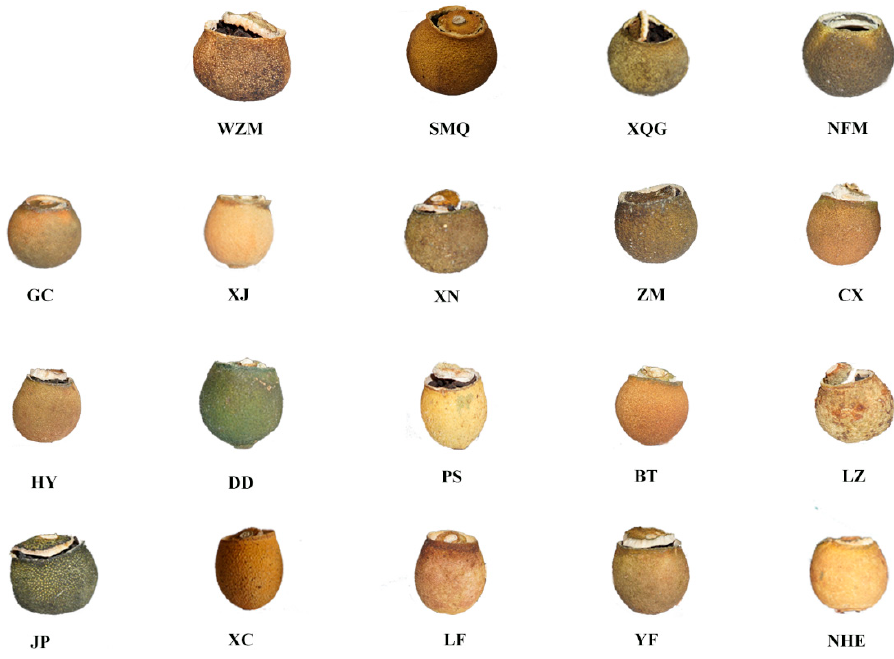
Figure 9. Samples of 19 types of citrus-tea.